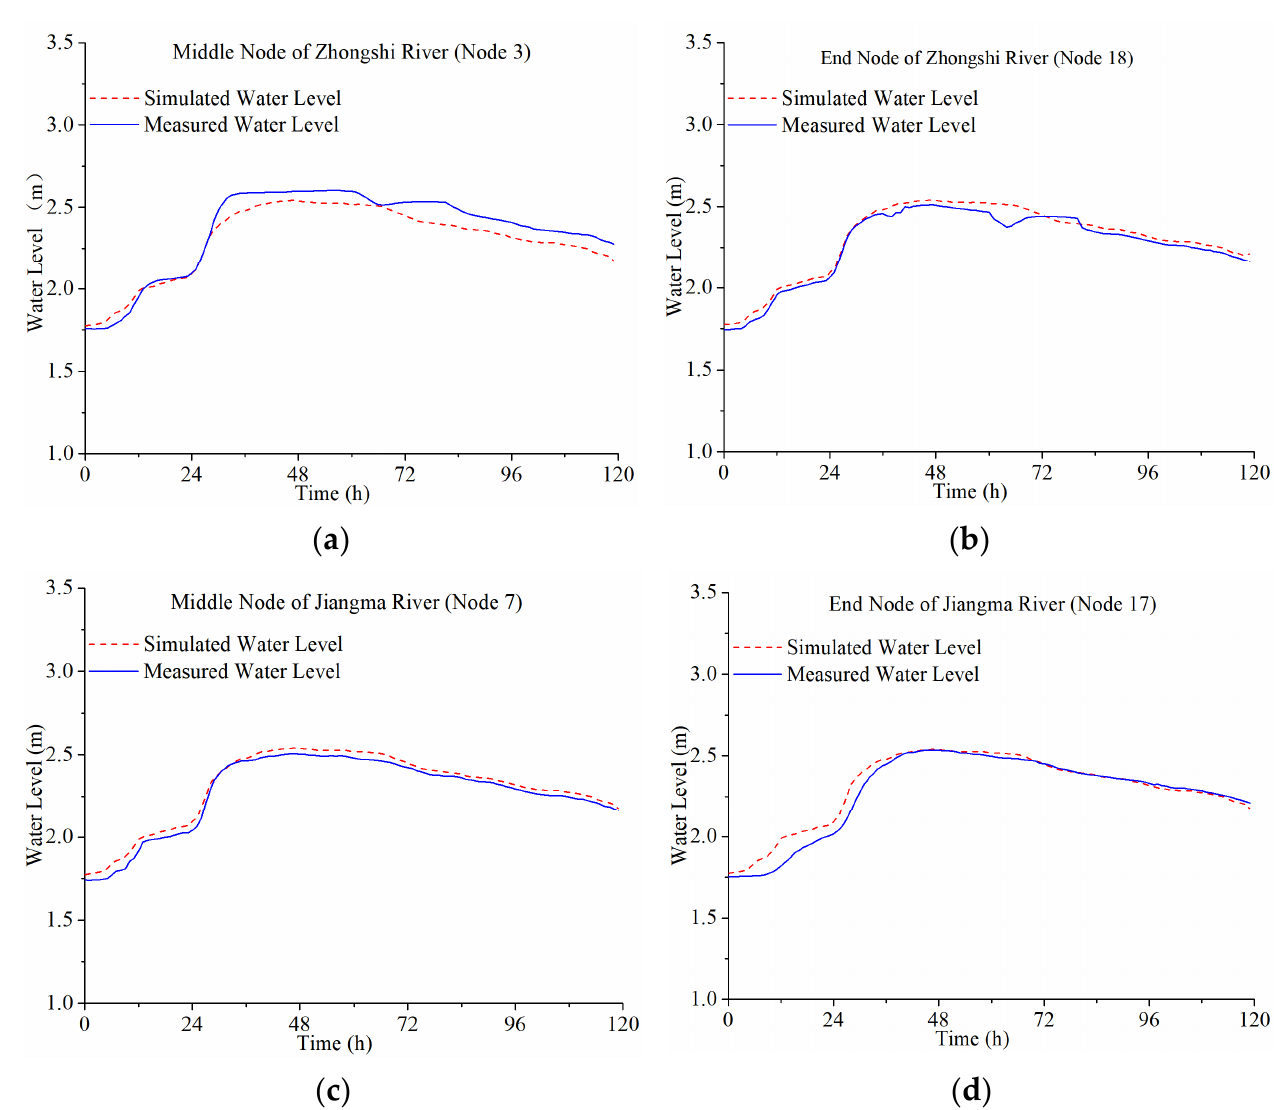
Figure 9. Curves of the measured and simulated processes of the river level at ( a ) Node 3, ( b ) Node 18, ( c ) Node 7, ( d ) Node 17 (Example 1).